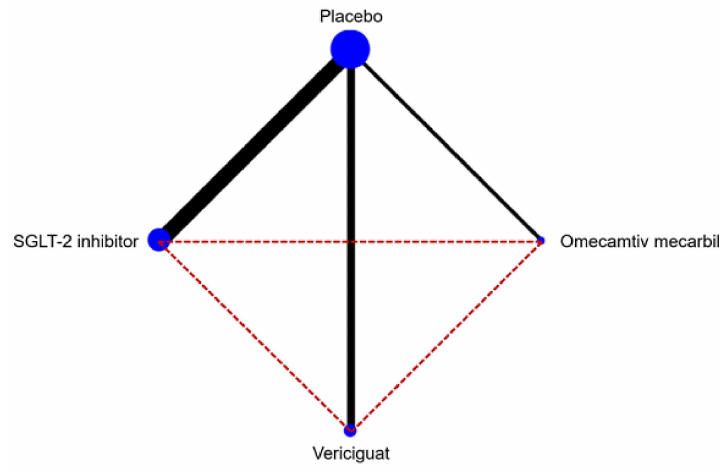
Figure 2. Network map of the study treatments. Table 1. Main characteristics of the included